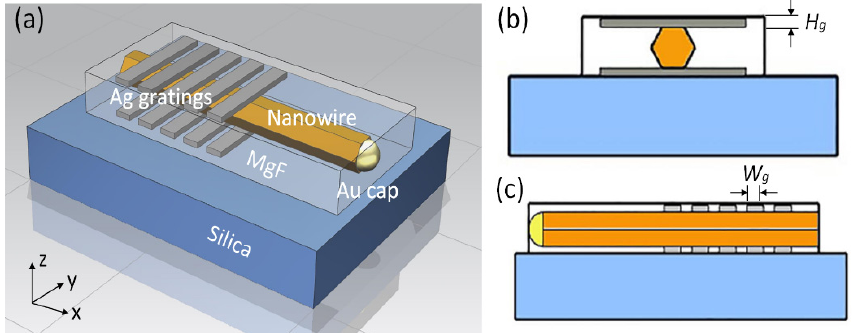
Figure 1. Schematic diagrams of the nanowire partially sandwiched in the double Ag gratings. ( a ) 3D structure, ( b ) Y-Z cross-section, ( c ), X-Z cross-section.